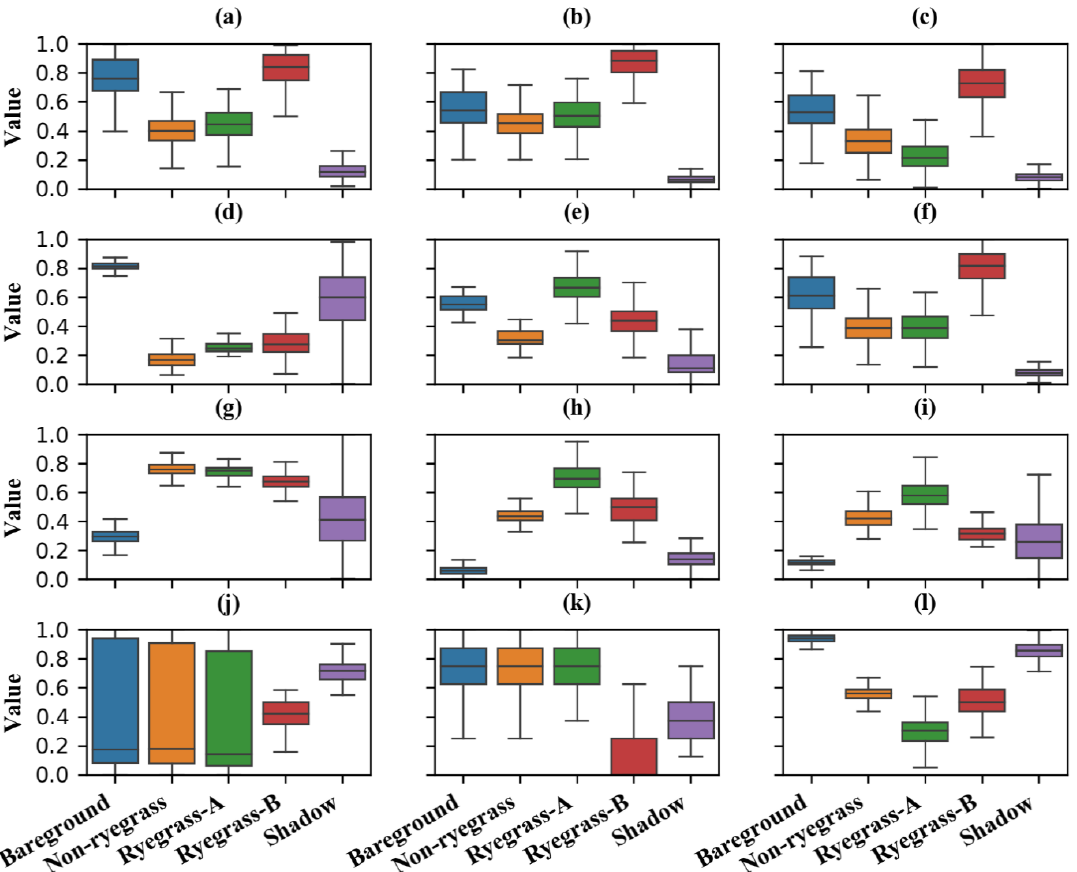
Figure 3. Boxplots showing the distribution of features for each of the user-defined classes, with X- and Y-axis being the user-defined classes and corresponding normalized values, respectively. The colored portion of boxplots shows inter-quartile range of the red band ( a ), green band ( b ), blue band ( c ), hue ( d ), saturation ( e ), value ( f ), Visible Atmospheric Resistant Index ( g ), Triangular Greenness Index ( h ), Excess Greenness Index ( i ), wavelet transformed coefficients mean ( j ), wavelet transformed coefficients standard deviation ( k ), and principal component 1 ( l ).